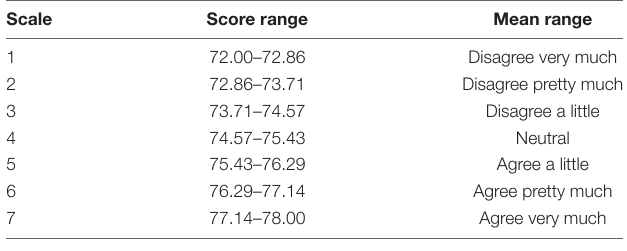
ORI, Opinions Relative to Integration of Students with Disabilities. TABLE 3 | Attitudes of middle school teachers toward inclusion.